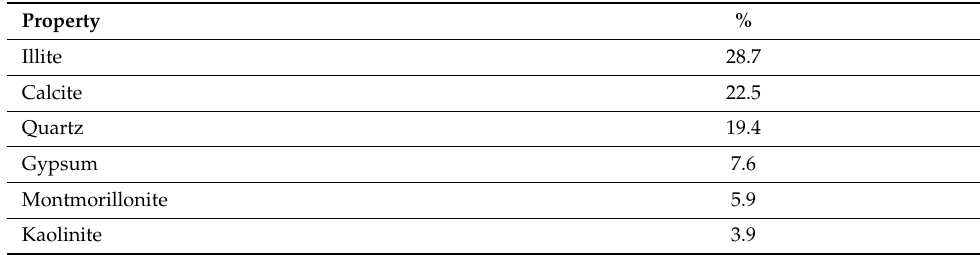
Table 1. Soil sample composition by a semiquantitative mineralogical analysis performed using X-ray